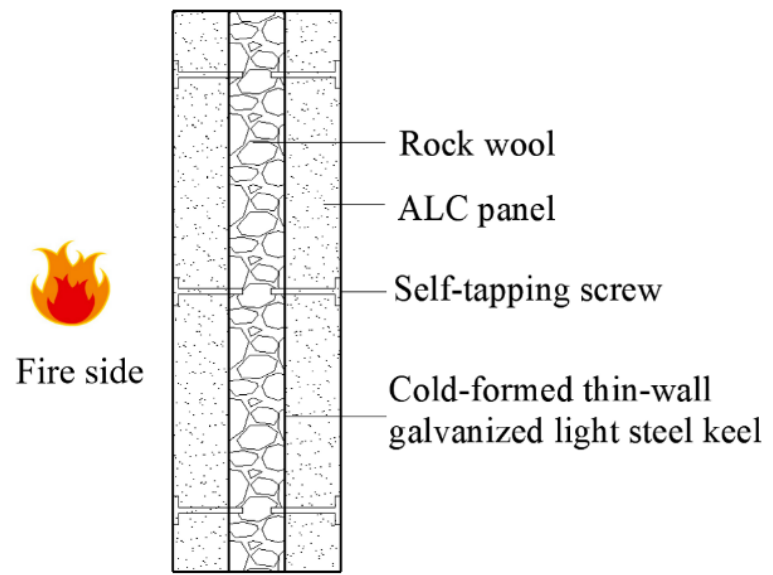
Figure 2. The structure of the sandwich wall panel.